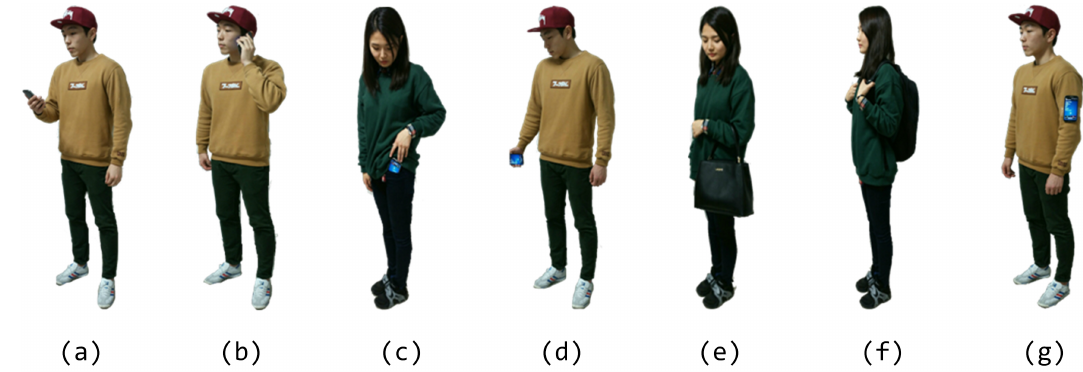
Figure 5. Device pose ( a ) texting; ( b ) calling; ( c ) pocket; ( d ) swinging; ( e ) handbag; ( f ) backpack; ( g )